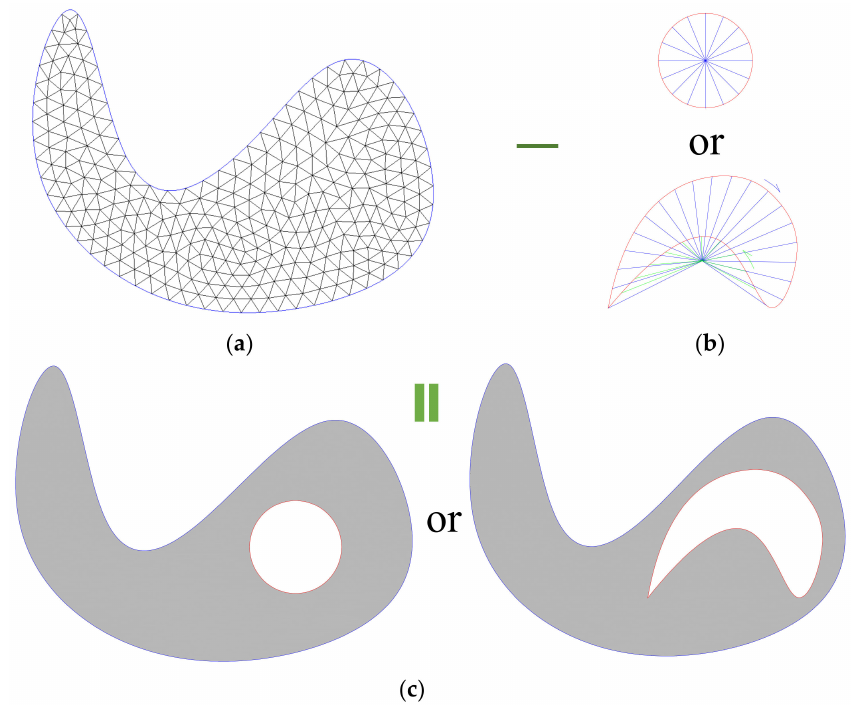
Figure 1. Integration subtraction technique ( a ) − ( b ) = ( c ): ( a ) a predesigned integration domain with isogeometric triangular meshes (along the blue boundary) and finite element (FE) triangular meshes; ( b ) di ff erent holes integration domains with homotopic meshes to be subtracted; ( c ) equivalent material domains for di ff erent